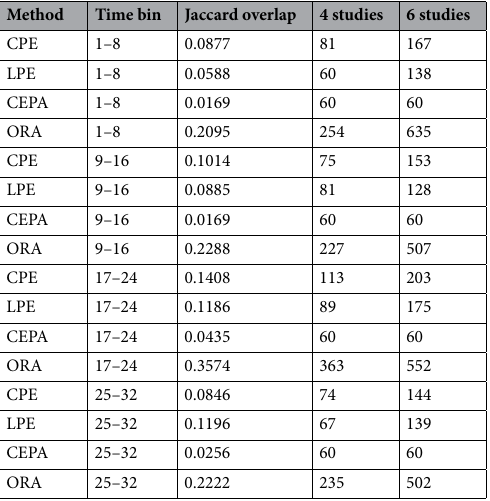
Table 2. Jaccard overlap between the selected pathways across the 4 study and the 6 study pathways LIMMA was used to normalize the data for subject identifier. The final two columns are the number of pathways selected by the method using the stated training dataset (4 or 6 studies). The CPE configuration is pre- computed, directed edges with PageRank centrality.